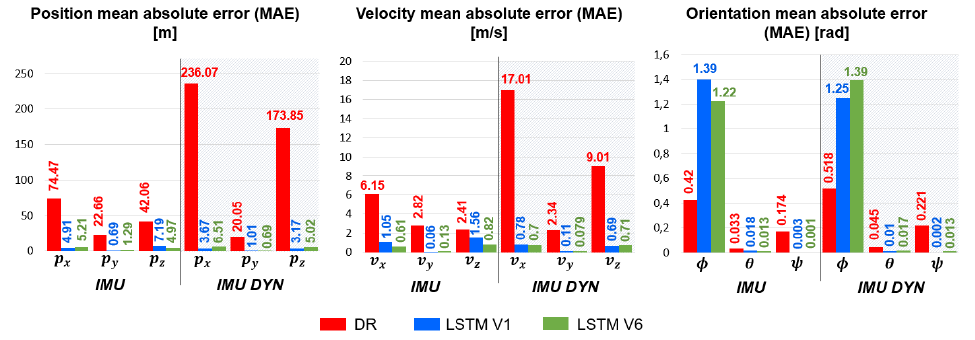
Figure 11. Position, velocity and orientation MAE average C MAE obtained by LSTM IMU , V LSTM IMU , V , LSTM IMU DYN , V 6